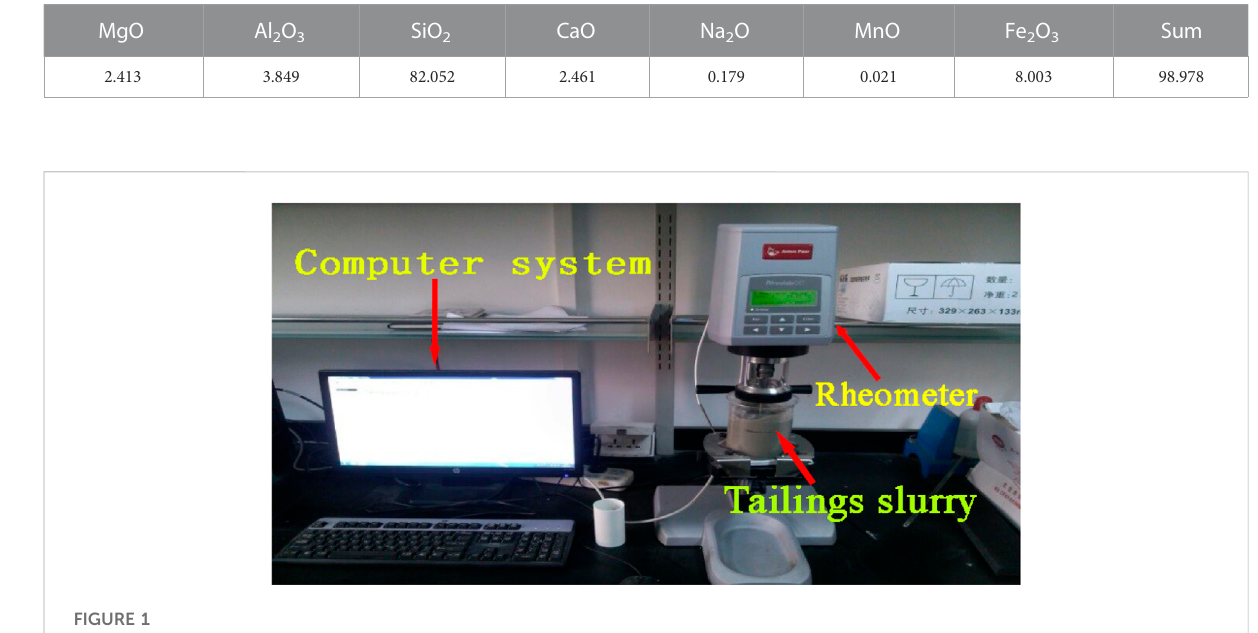
FIGURE 1 RheolabQC